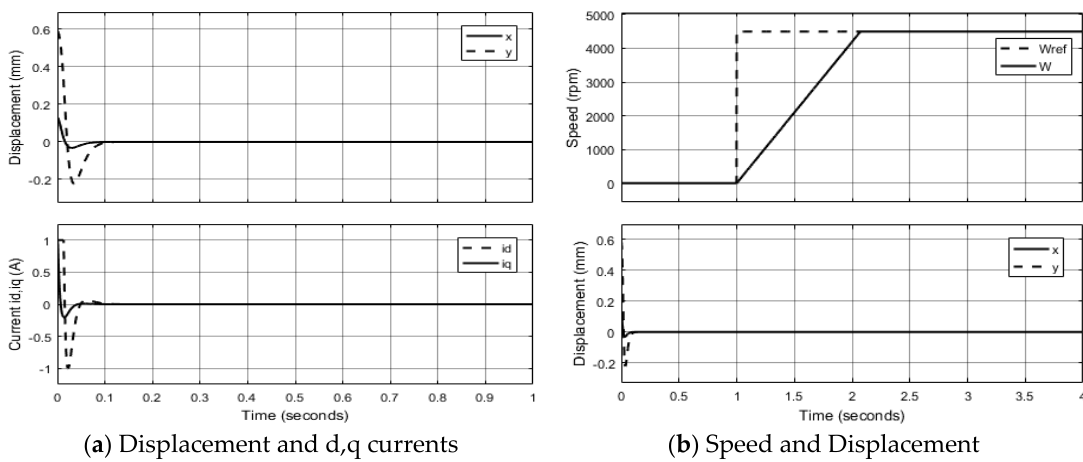
Figure 14. Responses of displacement, currents and speed when the motor has no load.